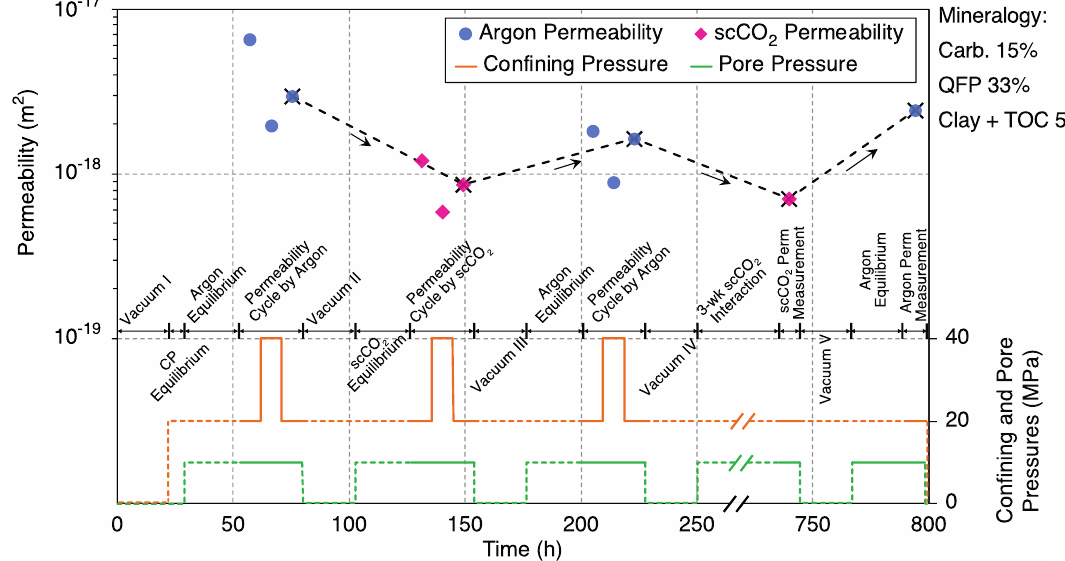
Figure 10. Permeability changes for sample 1-42-3H.